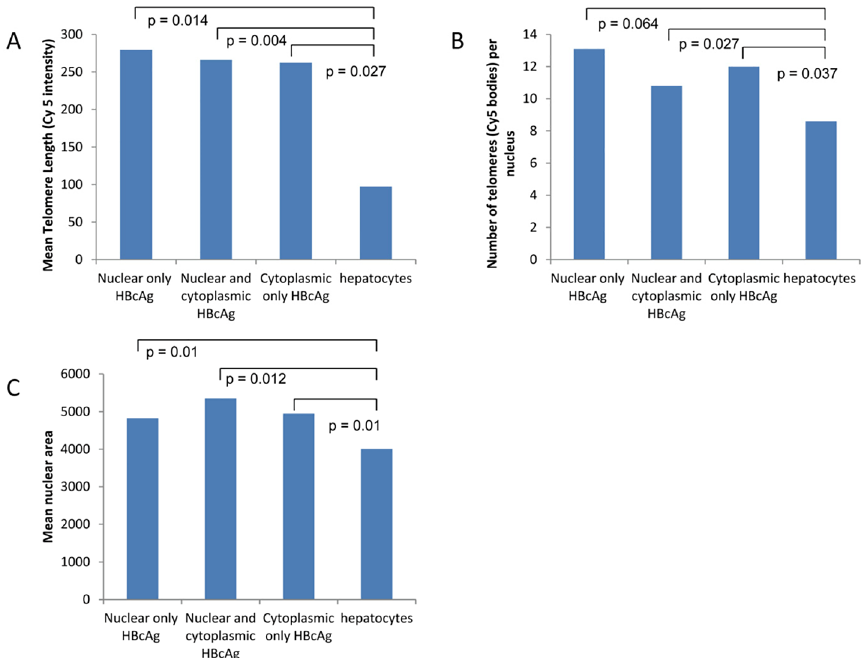
Fig 7. Telomere length, telomere number and nuclear area according to the subcellular location of